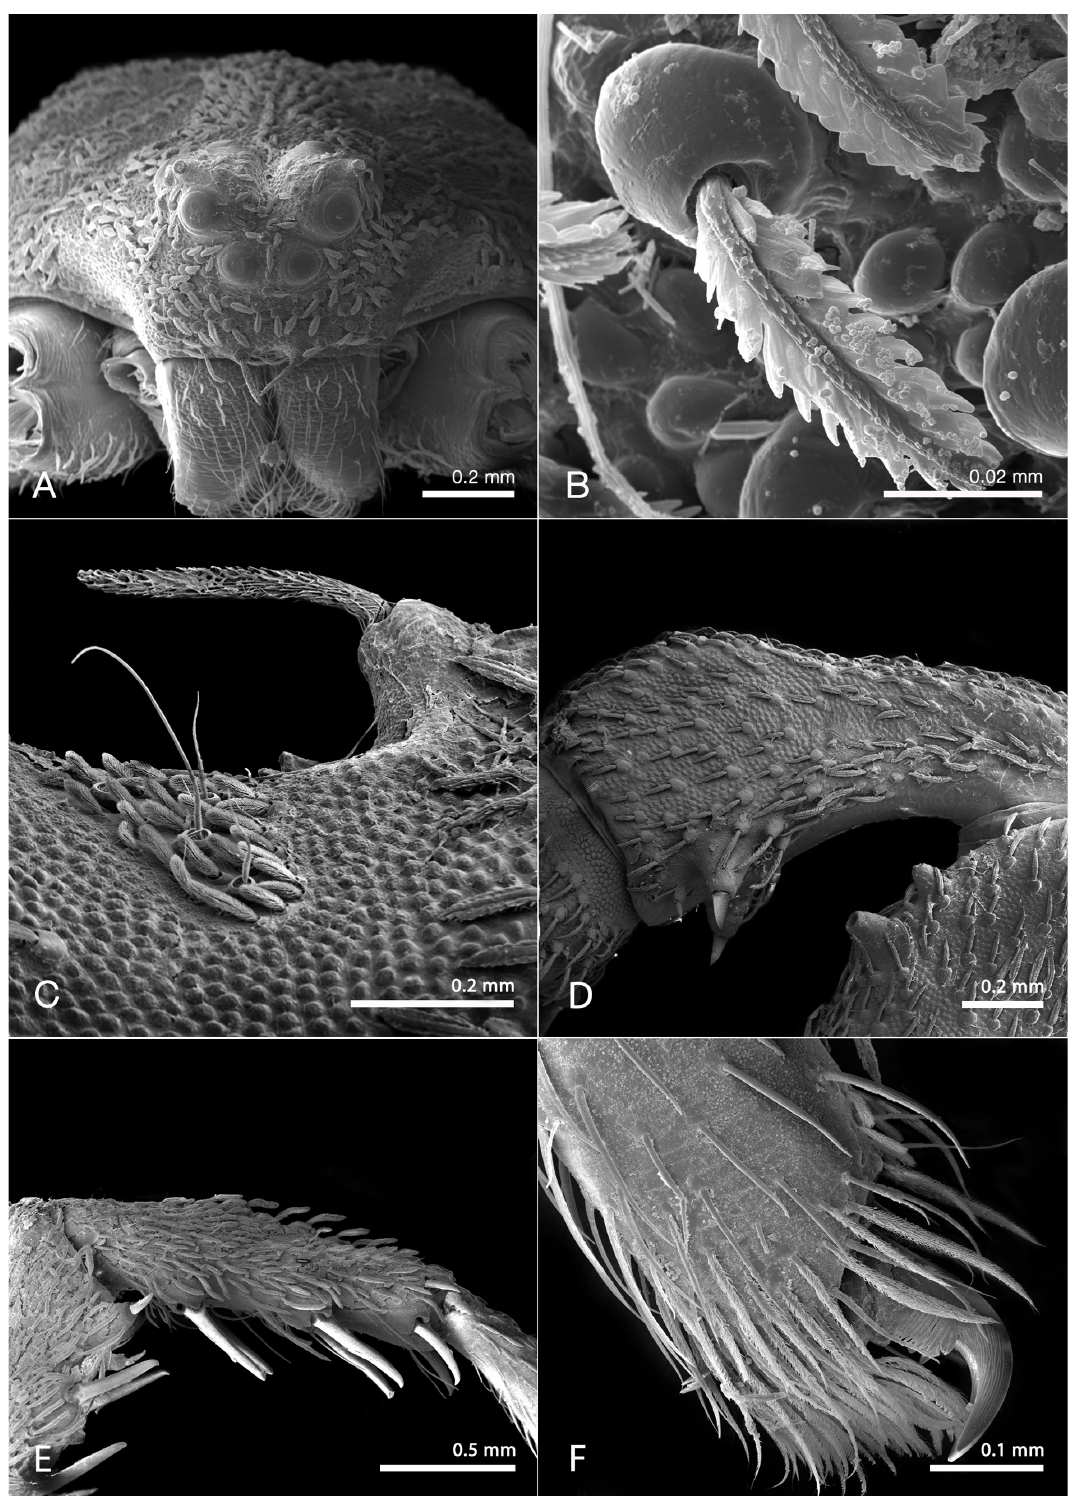
Fig. 1. Scanning electron microscopy of a male of Kryptochroma pentacantha (Mello-Leitão, 1929) gen. et comb. nov. (MCTP 7362). A . Prosoma, frontal view. B . Detail of a leaf-shaped setae and its spherical socket. C . Sensorial pit preceeded by a plumose macrosetae on tibia I. D . Pair of ventral macrosetae on patella I. E . Metatarsal macrosetae. F . Tarsal claw and detail of setae